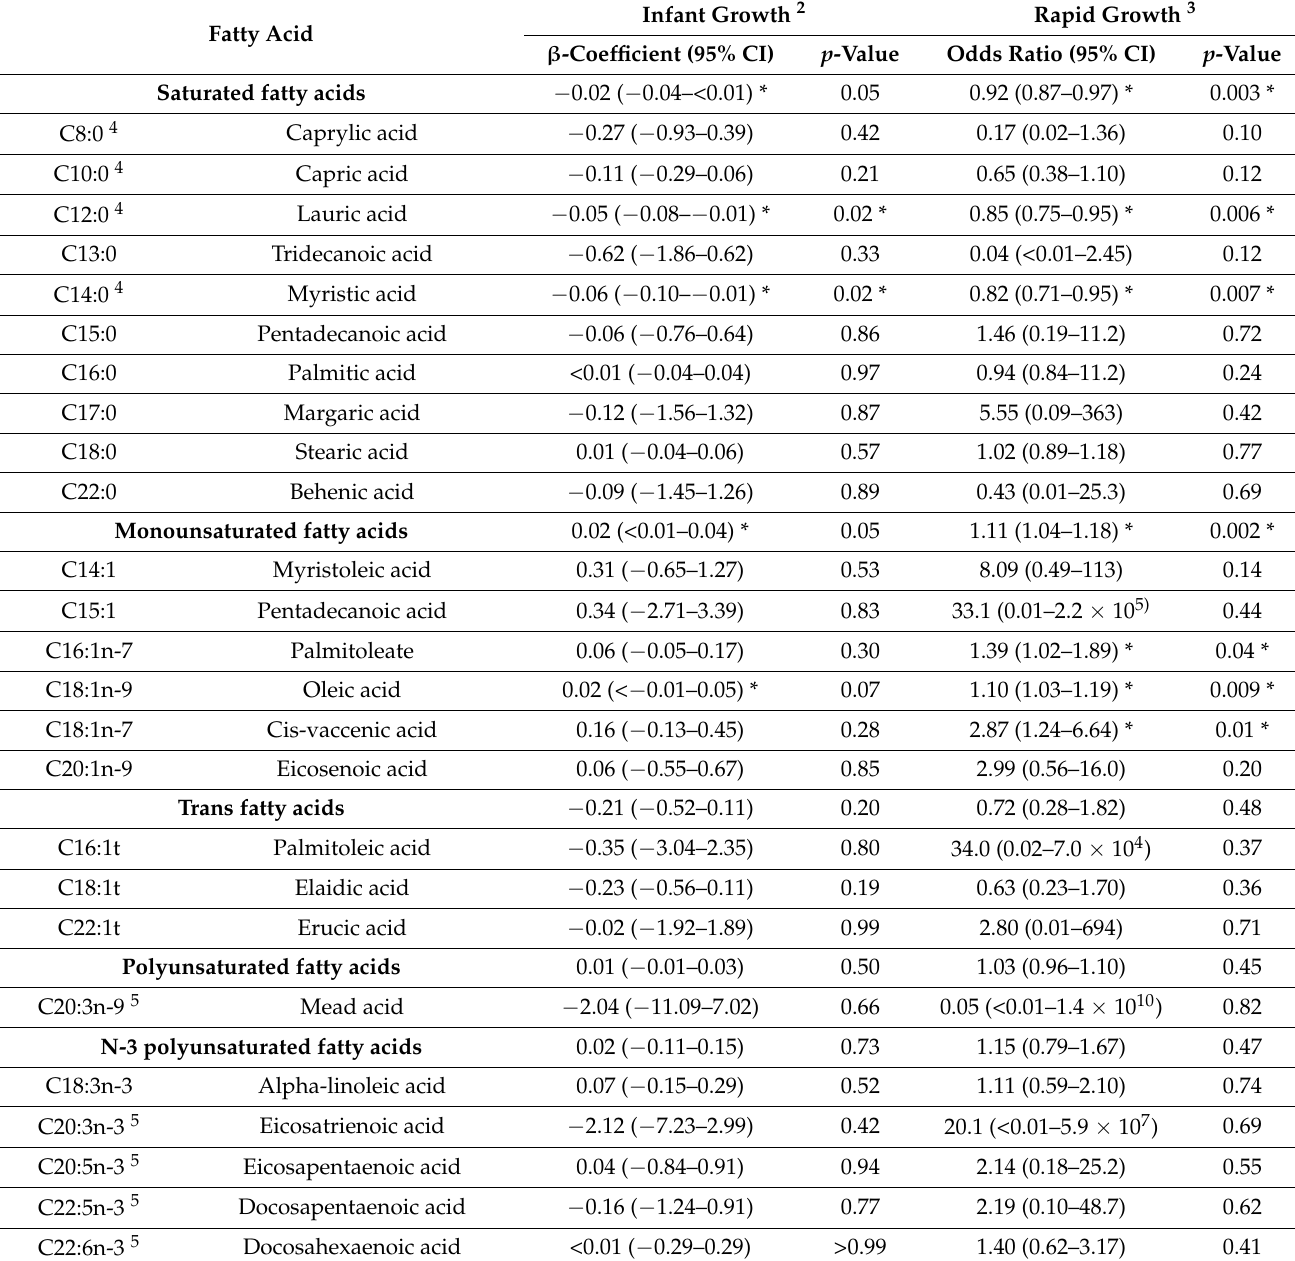
Table 5. Associations between triglyceride fatty acid percent composition 1 in human milk and infant